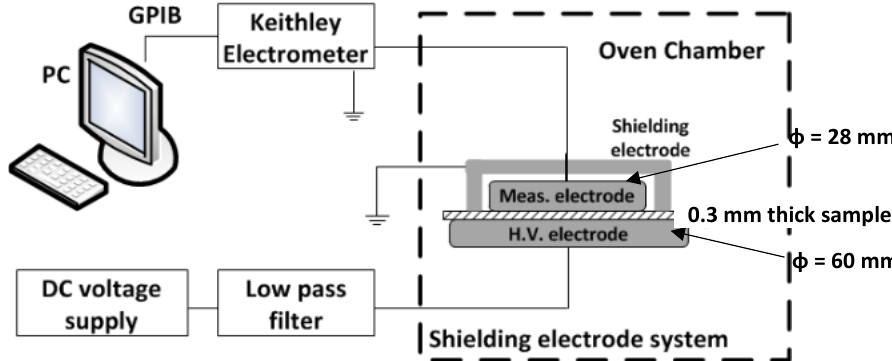
Figure 1. Setup of electrical conductivity measurements.